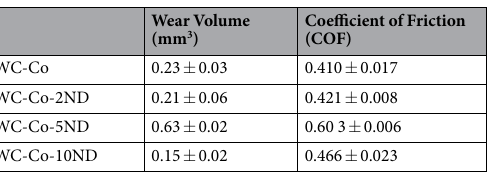
Table 2. Macroscale tribological properties of WC-Co and composite samples.